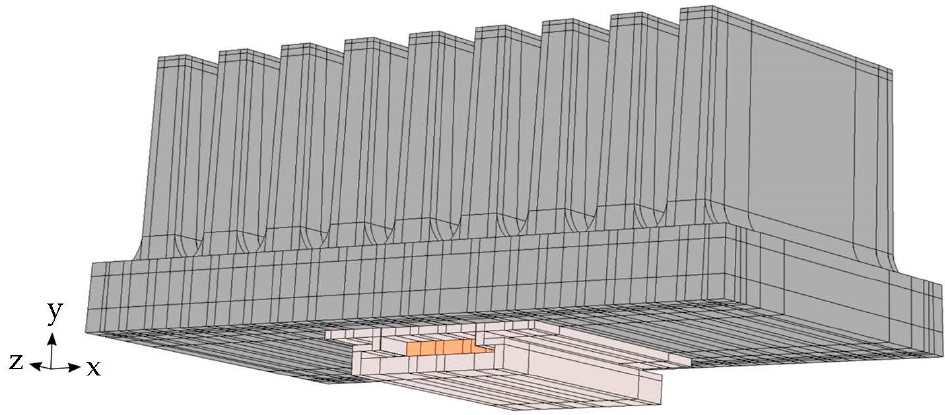
Figure 8. Geometry of the numerical model. Dark grey—heat sink, light grey—aluminum body of the heater, orange—active heater domain.